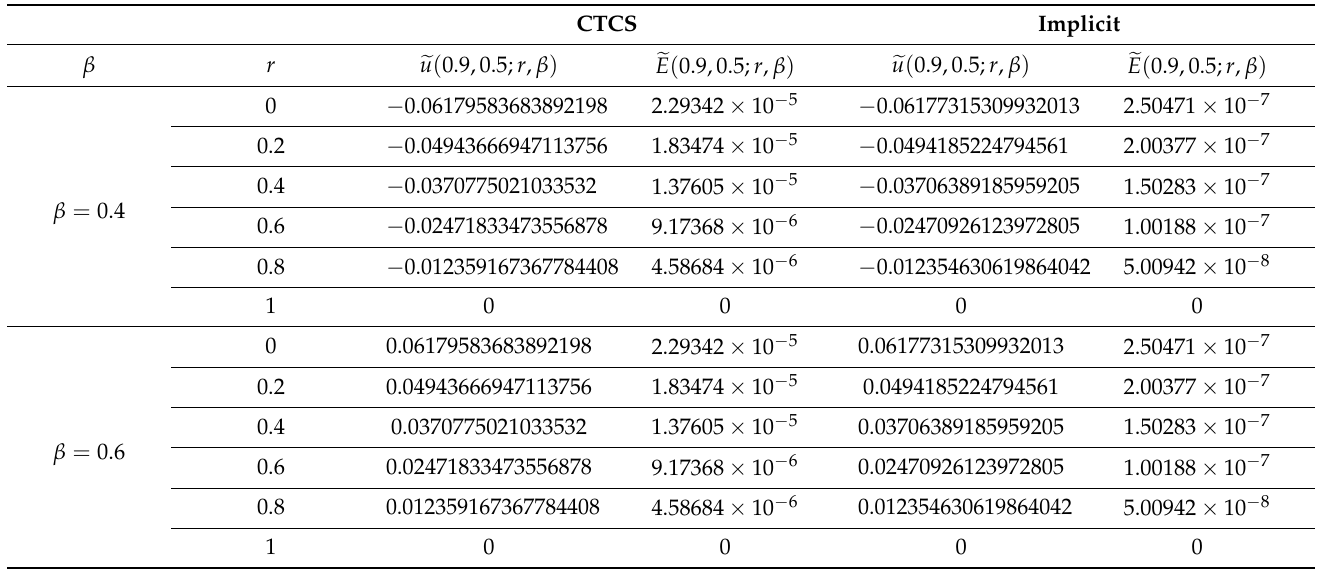
Table 2. Numerical solution of Equation (31) by CTCS and implicit at t = 0.05 and x = 0.9 for r , β ∈ [ 0,1 ]